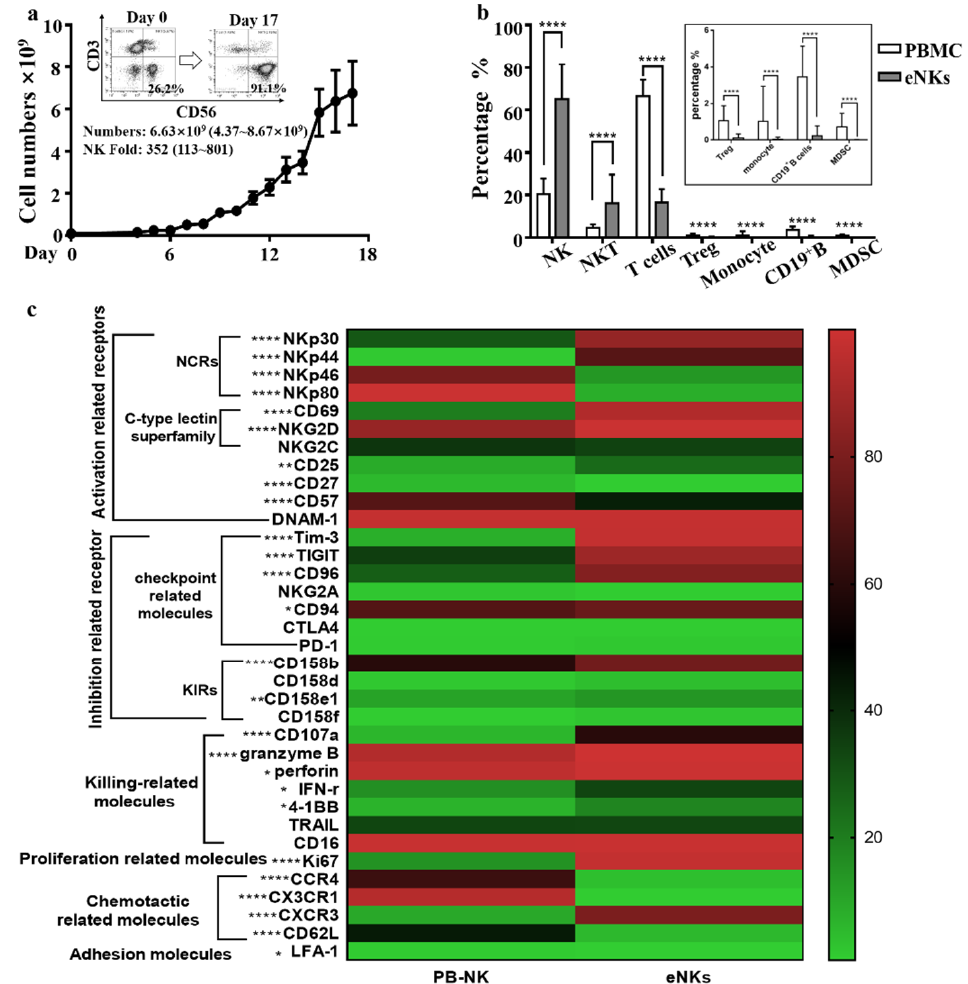
Figure 1. NK cells with enhanced cytotoxic activity were expanded ex vivo. PBMCs were isolated and cultured using a feeder cell-free NK cell expansion system. After 15 to 17 days of culture, expanded cells were harvested and identified. ( a ) A curve of the total number of expanded cells was generated for the expansion period. Data are shown as mean ± SD ( n = 32). Inset images show the purity of NK cells before (Day 0) and after (Day 17) expansion from one representative experiment. ( b ) The proportion of different types of immune cells before and after PBMC expansion were determined for comparison by two-tailed paired Student t -test ( n = 28). ( c ) Heat map showing the expression levels of surface receptors and intracellular granule components in CD3 − CD56 + NK cells before and after expansion ( n = 31). Significance was determined by Wilcoxon signed-rank test. * p < 0.05; ** p < 0.01; **** p <